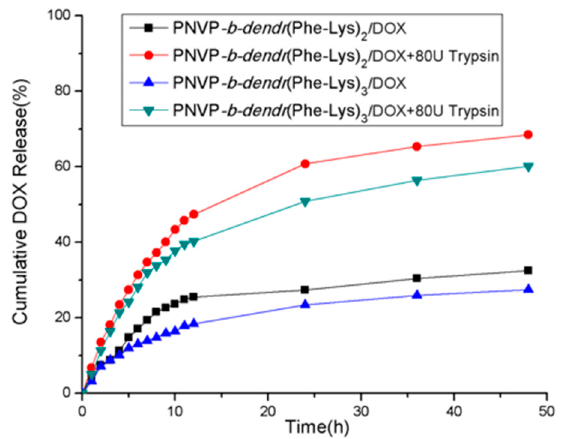
Figure 8. Release profile of drug-loaded micelles over time after addition of trypsin.